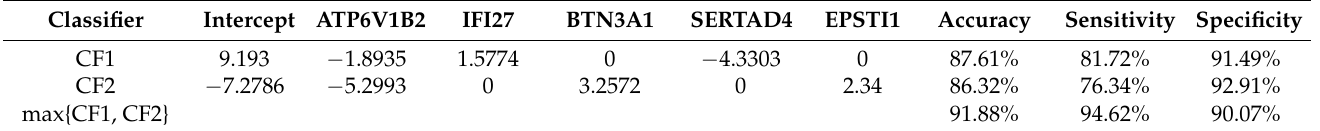
Table 3. First dataset: Characteristics of the top-performing five-gene classifier. CF1 and CF2 are the first and second individual classifiers for data of COVID-19 patients vs. other viral ARIs and non-viral infection patients.